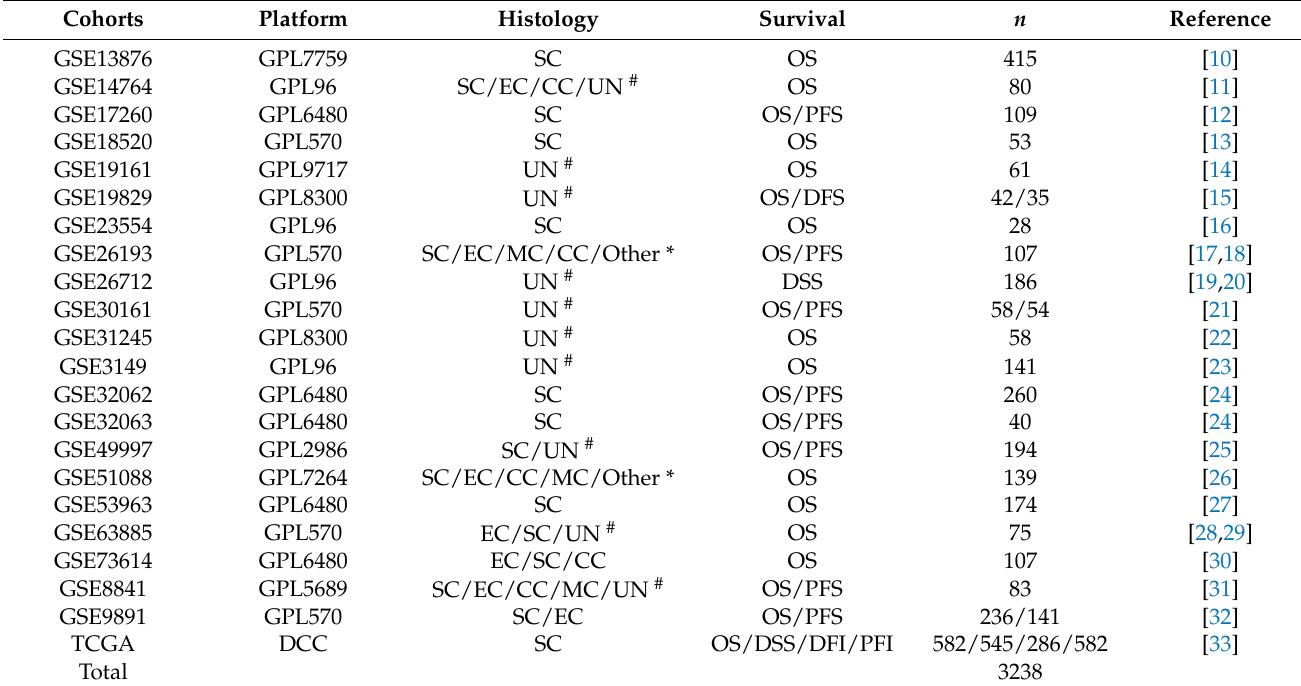
Table 2. Ovarian cancer cohorts in